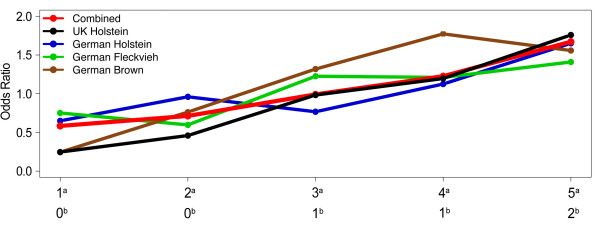
Odds Ratios of Diplotypes. Odds ratios (ORs) conferred by the diplotypes in each population and over all populations. The ORs were calculated using the absolute risks averaged across all five diplotypes as reference. aNumbers refer to diplotypes: (1) 23ins-12ins/23ins-12ins, (2) 23ins-12ins/23del-12ins, (3) 23del-12ins/23del-12del, (4) 23ins-12ins/23del-12del and (5) 23del-12del/23del-12del. bNumbers indicate number of deletion alleles at the 12-bp indel locus.